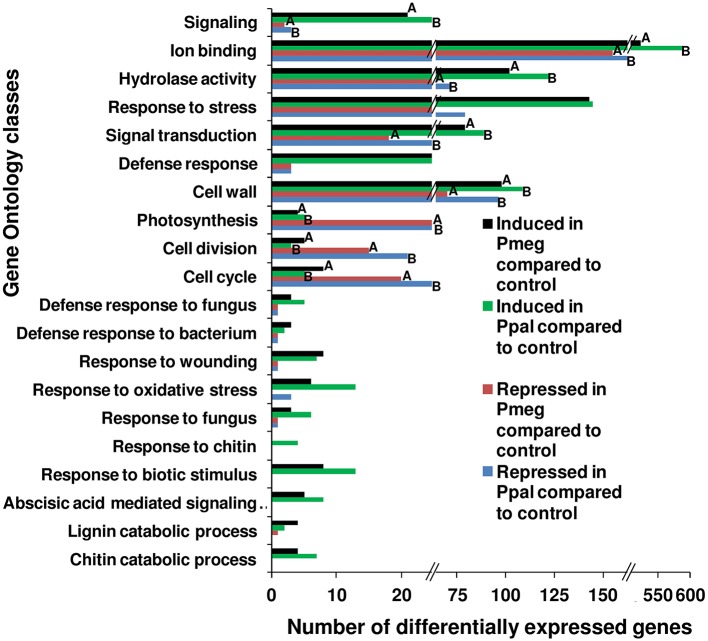
Shift in the number of differentially expressed genes among key biological processes involved in the disease response in Phytophthora megakarya and P. palmivora infected cacao pod husk samples. Differentially expressed genes were identified using RNA-Seq analysis between control and infected pod husk samples (at 3 dpi) and grouped into four categories, either up or down regulated (≥2-fold) for each species. Gene ontology (GO) analysis was carried out using the program Blast2GO (Conesa et al., 2005) comparing up and down regulated categories within species and up regulated categories and down regulated categories between species. Within GO classes, bars with same letters are significantly different (FDR < 0.05 along with P < 0.05) as estimated by Fisher's Exact Test within the Blast2GO suite. Where letters are not indicated, no differences were observed. Underlying data are shown in Supplementary Excel File S1, Sheet C and D.